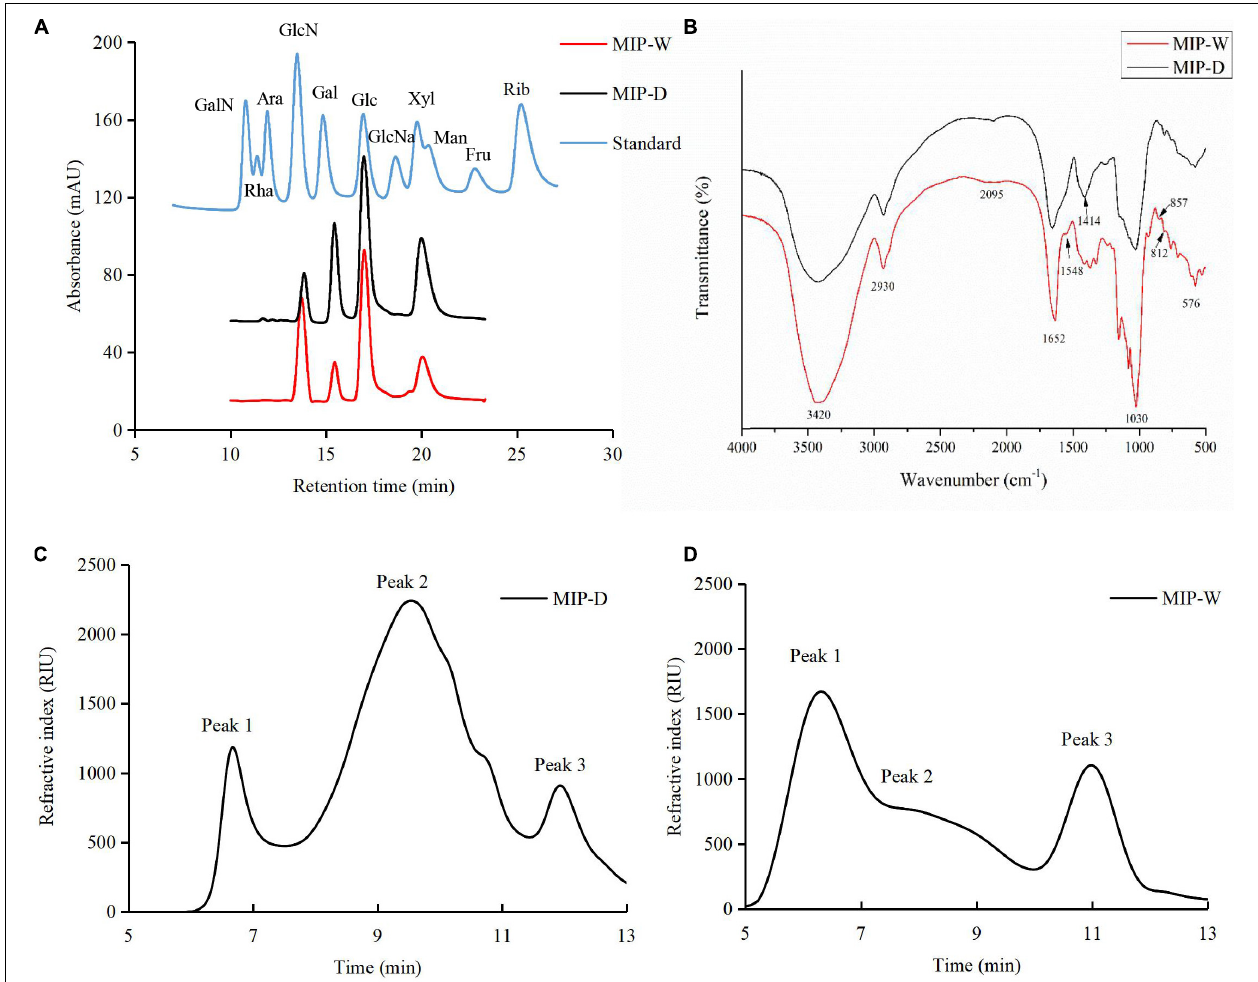
FIGURE 3 | (A) High performance liquid chromatography profiles of MIPs and monosaccharide standard; (B) fourier-transform IR (FTIR) spectra of MIPs over the frequency range of 4,000–5,000 cm − 1 ; high-performance gel permeation chromatography profiles of MIP-D (C) and MIP-W (D)